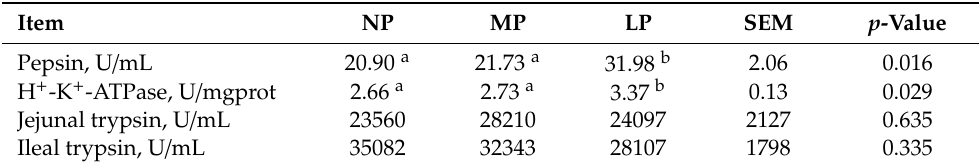
Table 3. Response of the digestive enzyme activity to di ff erent dietary protein levels in